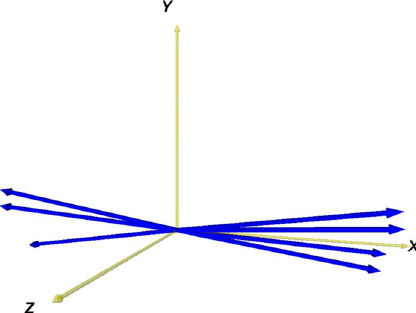
FIG. 2. (cid:1) Color (cid:2) A starburst configuration of observed variables is represented by blue